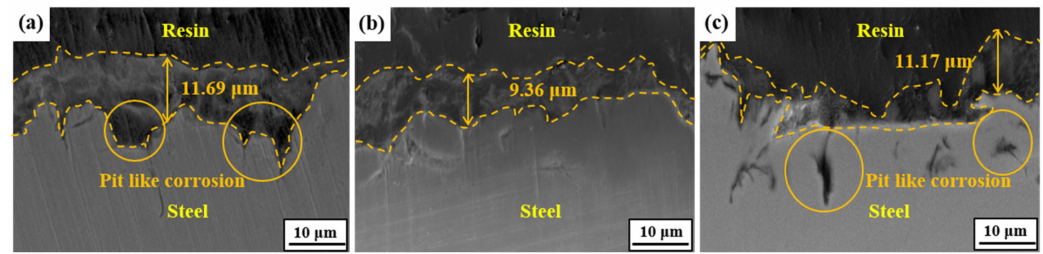
Figure 12. Cross-sectional images after immersion in a NACE solution with 0.05 M Na 2 S for four weeks: ( a ) Steel A, ( b ) Steel B, and ( c ) Steel